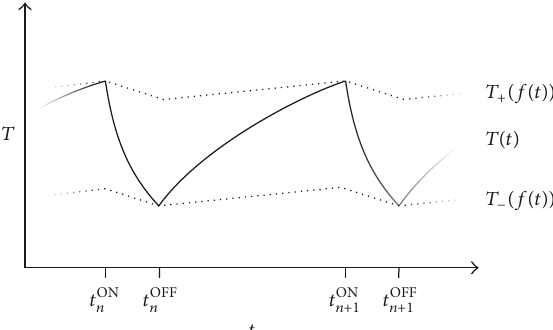
Figure 2: Illustration of the 𝑛 th and (𝑛 + 1) th switching events of the fully synchronised population and the frequency-sensitive temperature set points 𝑇 − (𝑓(𝑡)) and 𝑇 + (𝑓(𝑡))